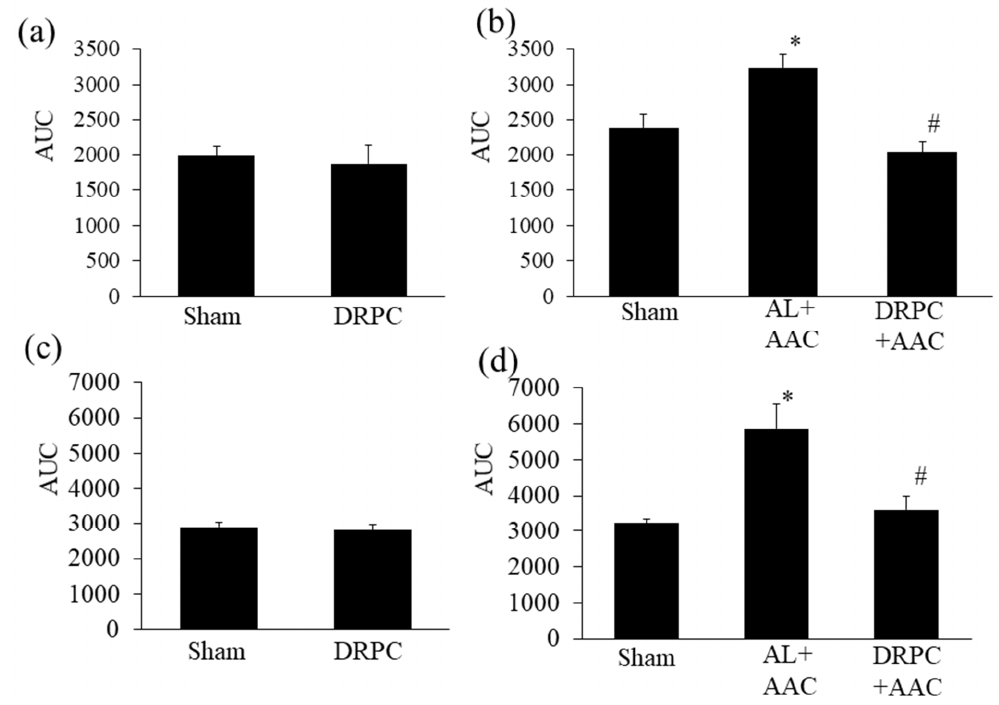
Nutrients 2021 , 13 , x FOR PEER REVIEW Figure 6. Effects of dietary restriction preconditioning on NADPH oxidase-dependent ( a , b ) and mitochondrial ( c , d ) superoxide production in LV before ( a , c ) and 2 weeks after surgery ( b , d ) (before surgery, Sham: n = 5, DRPC: n = 6, after surgery, Sham: n = 6, AL+AAC: n = 5, DRPC+AAC: n = 6). * p < 0.05 versus Sham, # p < 0.05 versus AL+AAC.